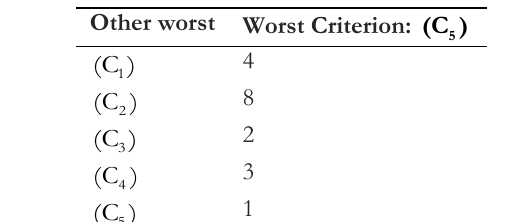
Table 3. OW pairwise